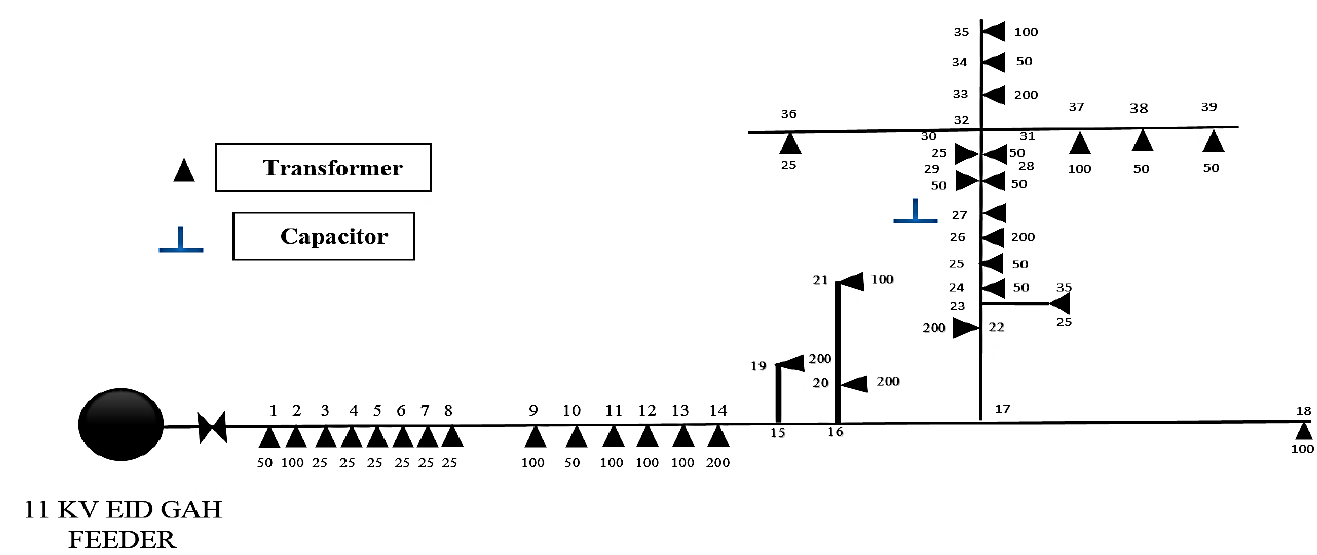
Fig. 5. Proposed (F2) line diagram of EidGah